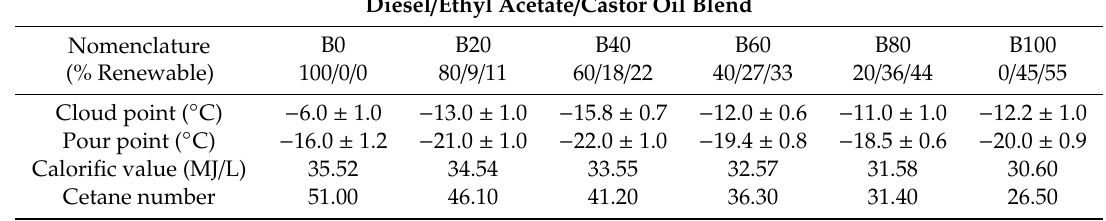
Table 6. Cloud point, pour point, calorific value and cetane number of diesel / ethyl acetate / castor oil triple blends (EA = 45%). Errors have been calculated from average three measurements and expressed as standard